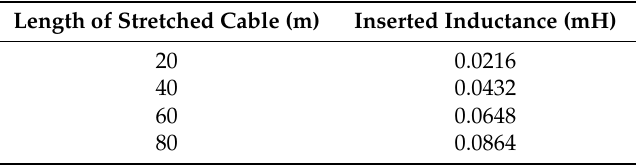
Table 2. Length of stretched cable x Inductance inserted.